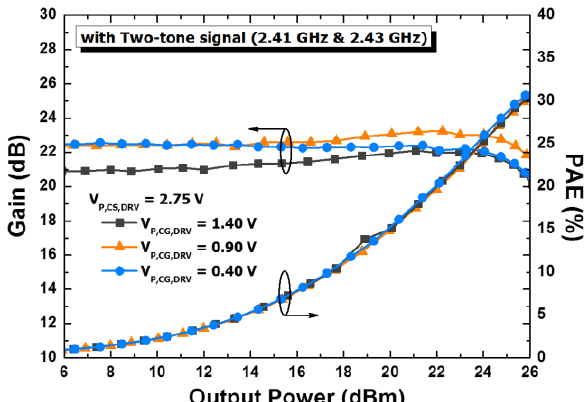
Figure 16. Measured results: power-added efficiency (PAE) and gain according to output power with a two-tone signal.